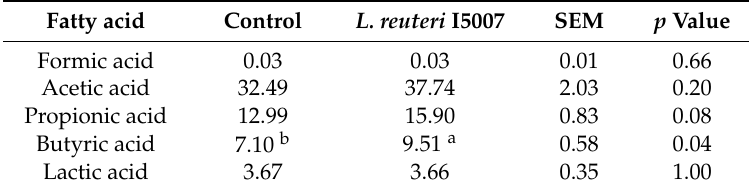
Table 3. Effects of L. reuteri I5007 on short chain fatty acid concentrations (mmol/kg, wet weight) in colonic digesta obtained from neonatal piglets 1 .